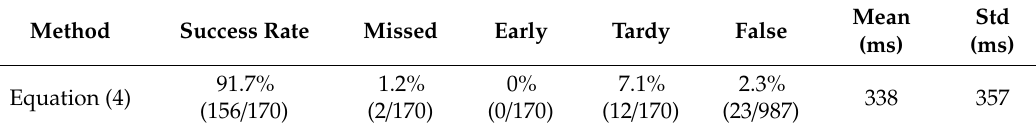
Table 4. Performance of Equation (4) for Campaigns